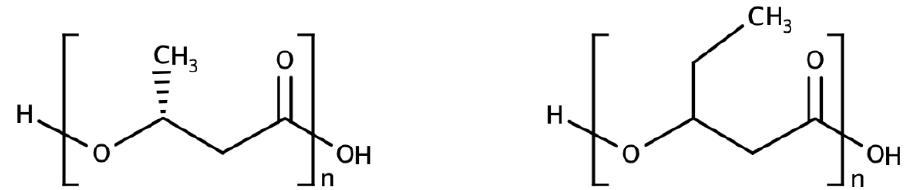
Figure 7. Chemical structures of poly-(R)-3-hydroxybutyrate (P3HB) and poly-3-hydroxyvalerate (PHV) (Adapted with permission from [29], available online, Wikimedia Commons, the free media repository).